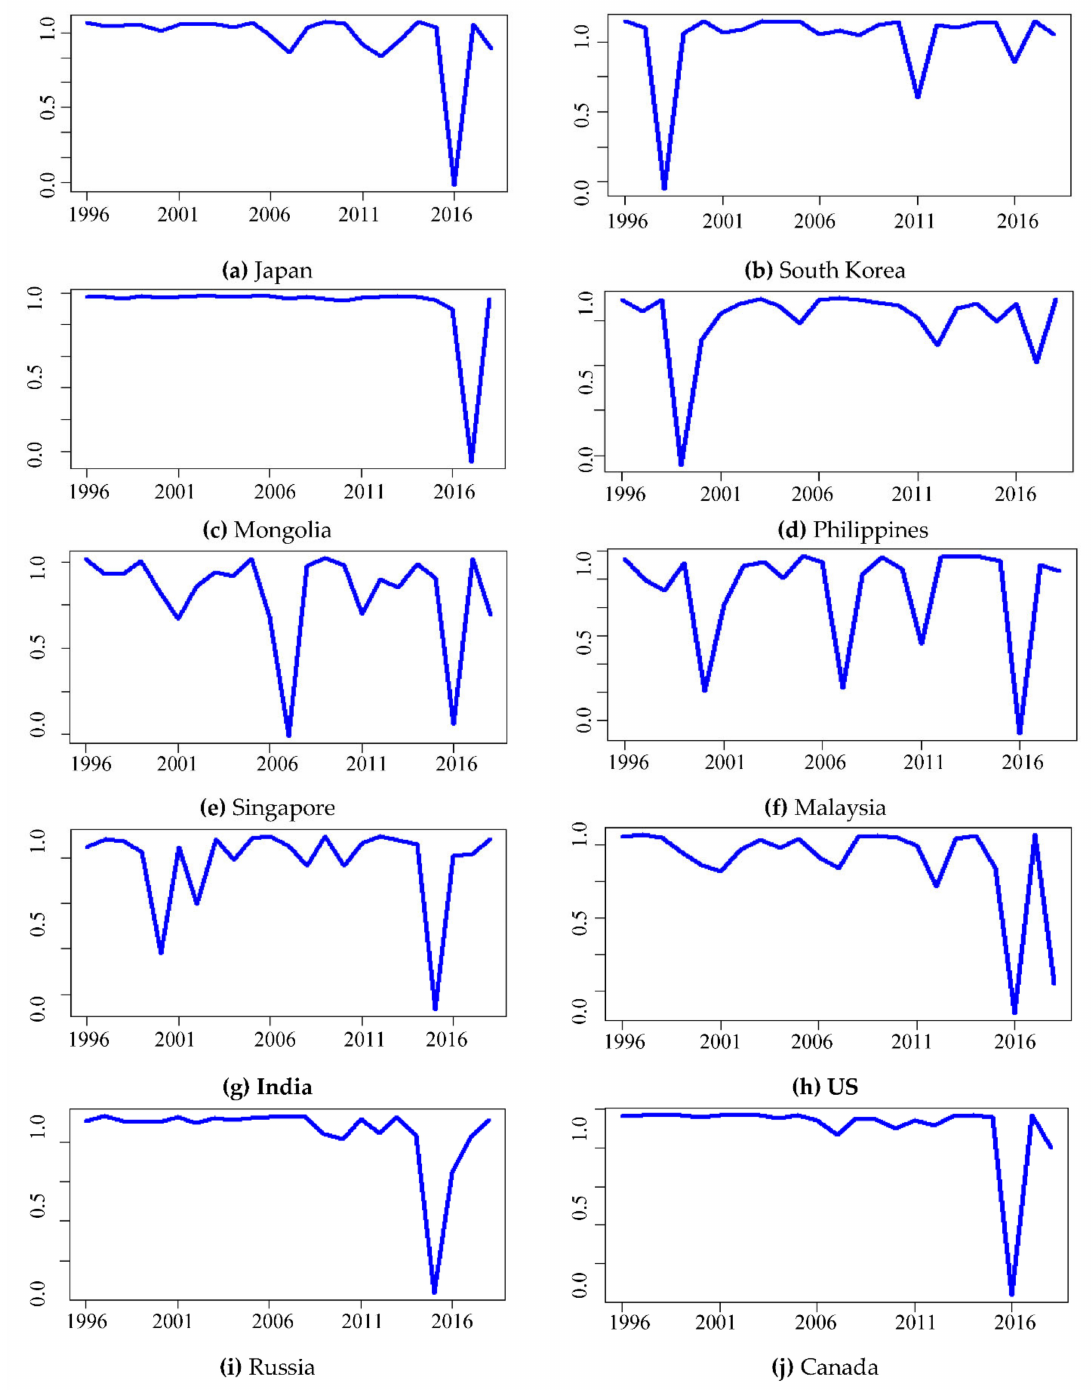
Figure 2. Filtered Probability of the high tourism arrival regime (regime 2) for ten source countries. Source: Author’s